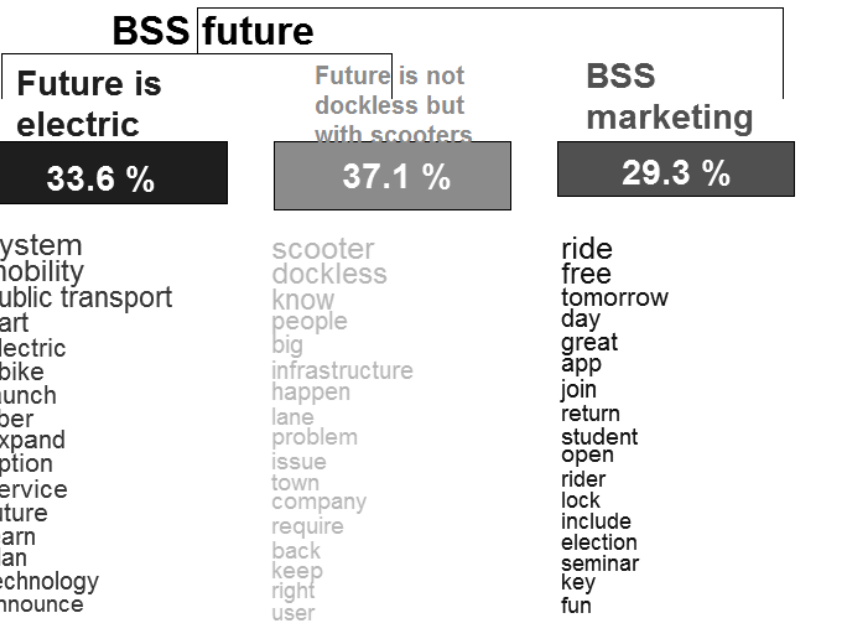
Figure 9. Quantitative topic clustering on tweets including the terms "future or "will" For the qualitative approach, we selected the tweets including the word future (n=149) to avoid tweets associated with marketing, in which 123 tweets were clustered in 9 topics (Figure 10). Because of the language used and the availability of the tweet poster’s username, while